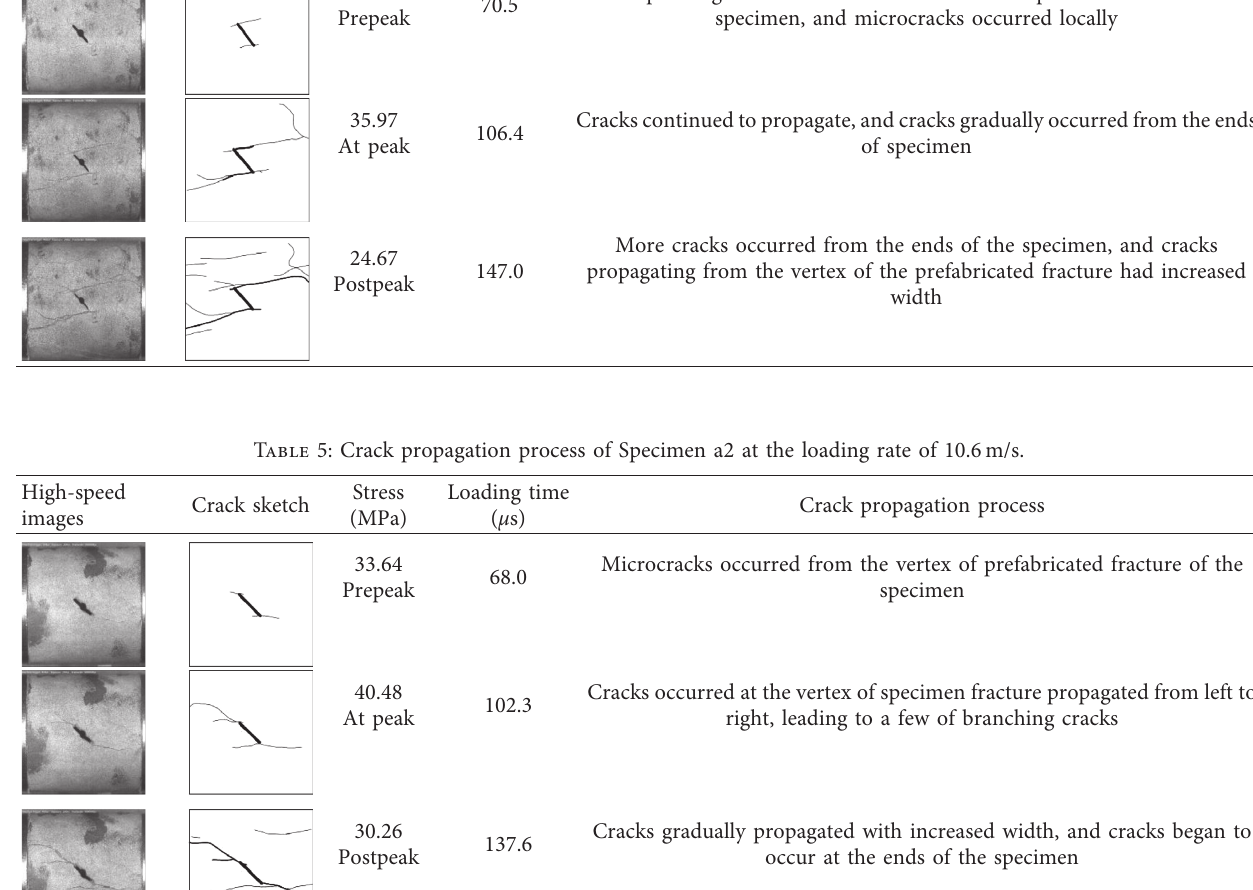
Table 4: Crack propagation process of Specimen a1 at the loading rate of 19.7m/s. High-speed images